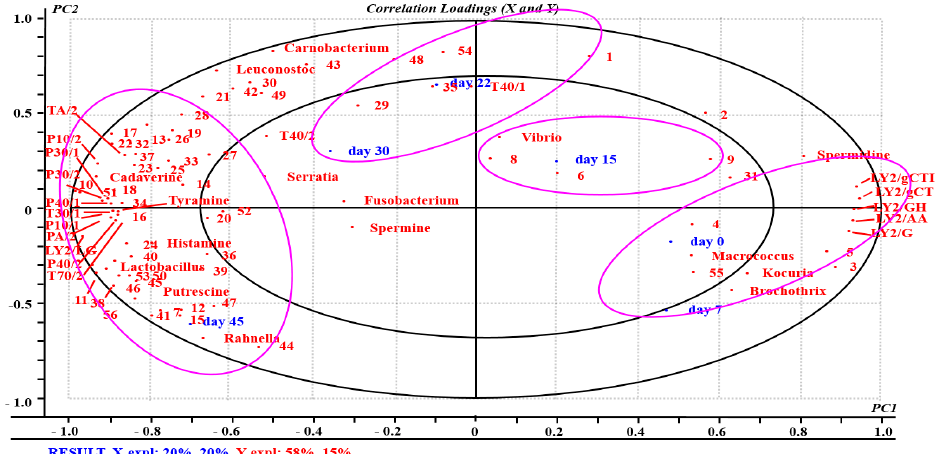
Figure 2. An overview of the variation found in the mean data from the partial least squares regression (PLSR) correlation loadings plot for bacon samples. The model was derived from e-nose sensors, VOCs, BAs and spoilage bacteria as the X -matrix and score values at different storage time as the Y -matrix. The concentric ellipses represent 100 and 50% explained variance, respectively. The code in PLSR corresponds to the 56 volatile compounds in Table 3. The 18 e-nose sensors are given in Figure 1a and Table S1. The regions within the purple ellipses are highly correlated with different variables.